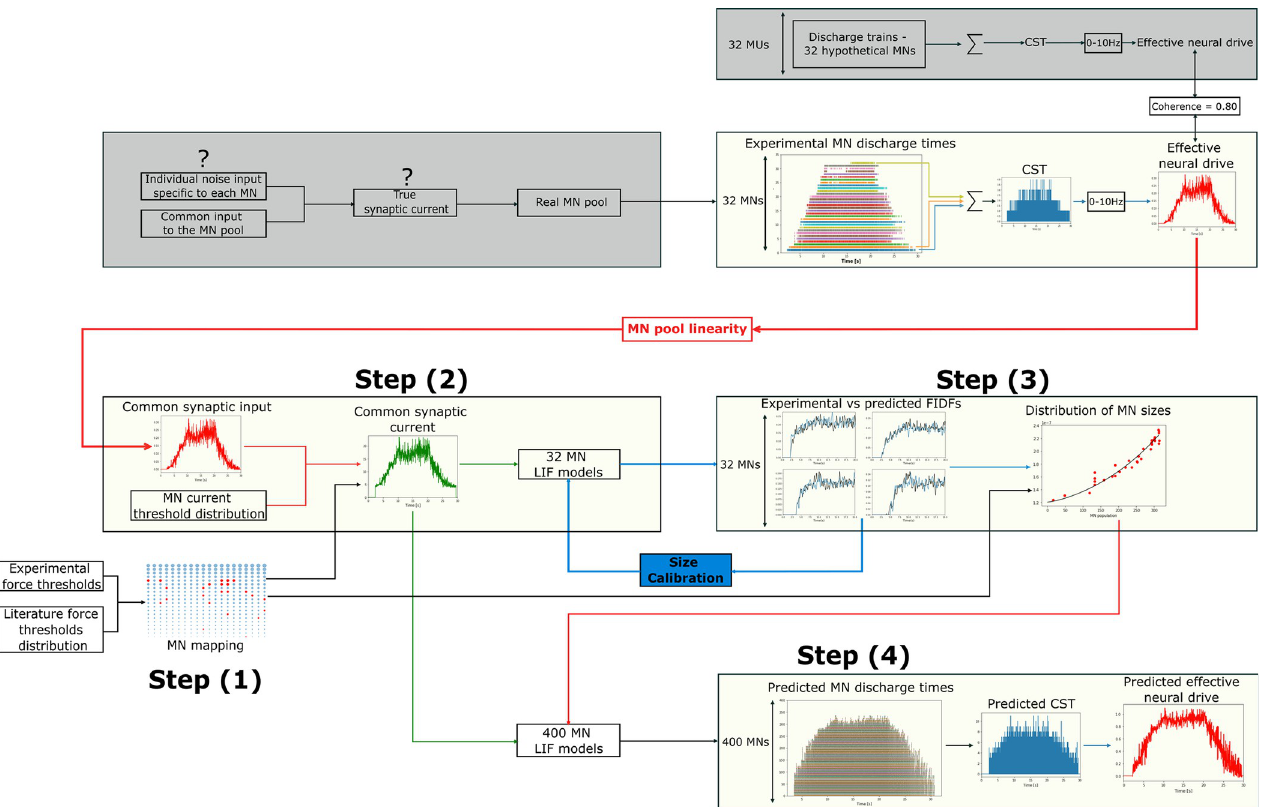
Fig 11. Detailed description of the 4-step workflow applied to the DTA 35 dataset. The firing activity of a fraction of the MN pool is obtained from decomposed HDEMG signals. These N r = 32 experimental spike trains provide an estimate of the effective neural drive to muscle and explain most of the MN identified MNs to the complete MN pool (Step (1)), literature knowledge on the typical distibution pool behaviour ( coherence = 0.8). From a mapping of the N r of I th in a mammalian MN pool, and using the linearity properties of the population of N r MNs, the current input I ( t ) is estimated (Step (2)). I ( t ) is input to N r LIF models of MN to derive, after a one-parameter calibration step minimizing the error between experimental and LIF-predicted FIDFs, the distribution of MN sizes across the complete MN pool (Step (3)). The distribution of MN sizes, which entirely describes the distribution of MN-specific electrophysiological parameters across the MN pool, scales a cohort of N = 400 LIF models which transforms I ( t ) into the simulated spike trains of the N MNs of the MN pool (Step (4)). The effective neural drive to muscle is estimated from the N simulated spike trains.